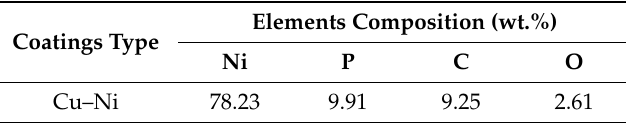
Table 5. Composition of surface coatings characterized by EDS.